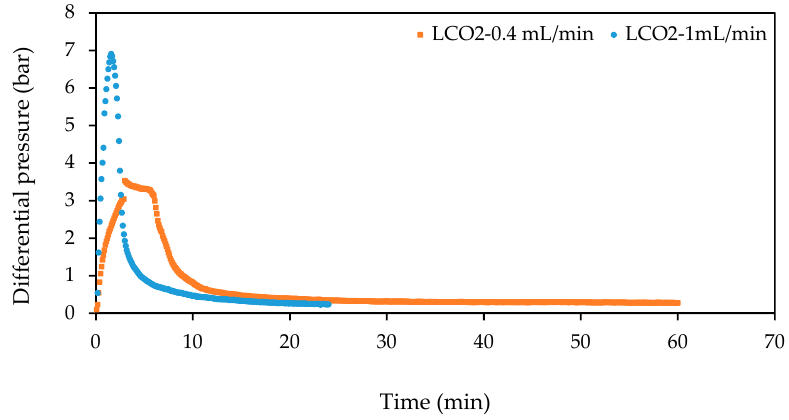
Figure 14. Effect of injection rate on the differential pressure profile of high-pressure GCO 2 –oil displacements conducted at 70 bar and 33 °C.